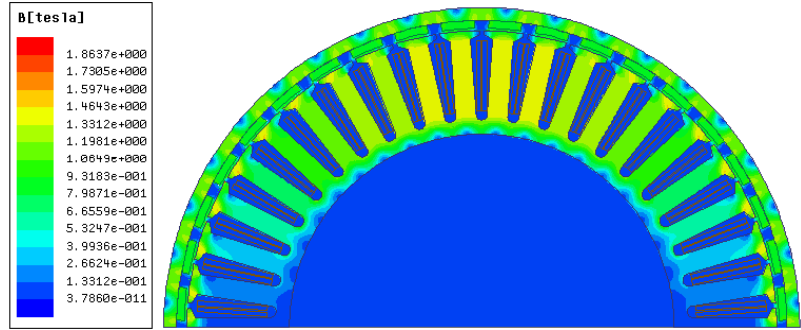
Figure 15. Inner flux density map of the motor under static condition.